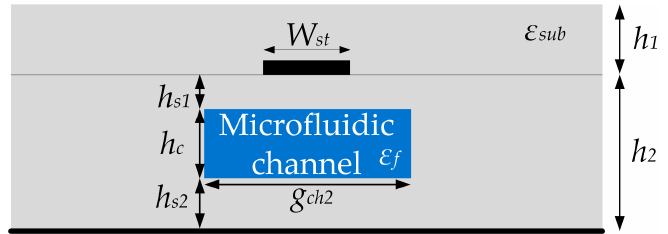
Figure 4. Cross-sectional view of the stub of the proposed resonator.